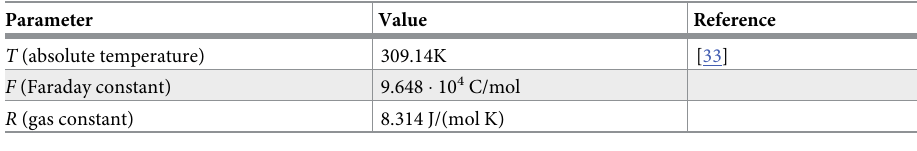
Table 3. Temperature and physical constants †